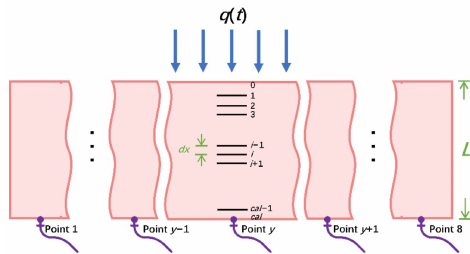
Figure 12. Geometry model of heat